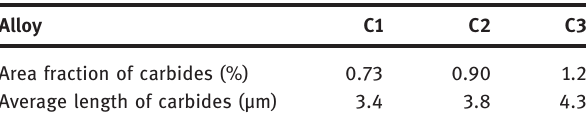
Table 3: The results for area fractions and average length of